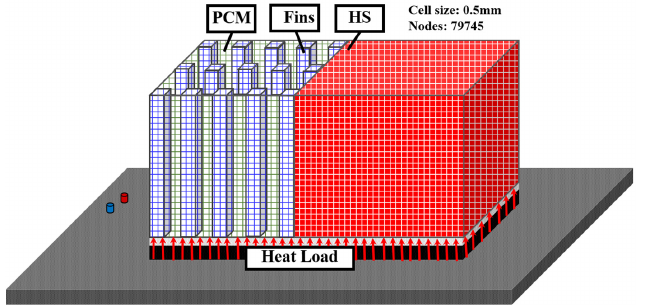
Figure 2. Meshing of the heat sink-phase change material (HS-PCM) system showing HS base plate, fins, PCM and side walls. Table 3. Sizing criteria for the heat sink model. Table 3. Sizing criteria for the heat sink model. Sizing Criteria Description Size function Curvature Relevance Center Fine Sizing Criteria Description Smoothing High Size function Curvature Growth rate 1.2 Relevance Center Fine Nodes 79,745 Smoothing High Growth rate 1.2 Nodes